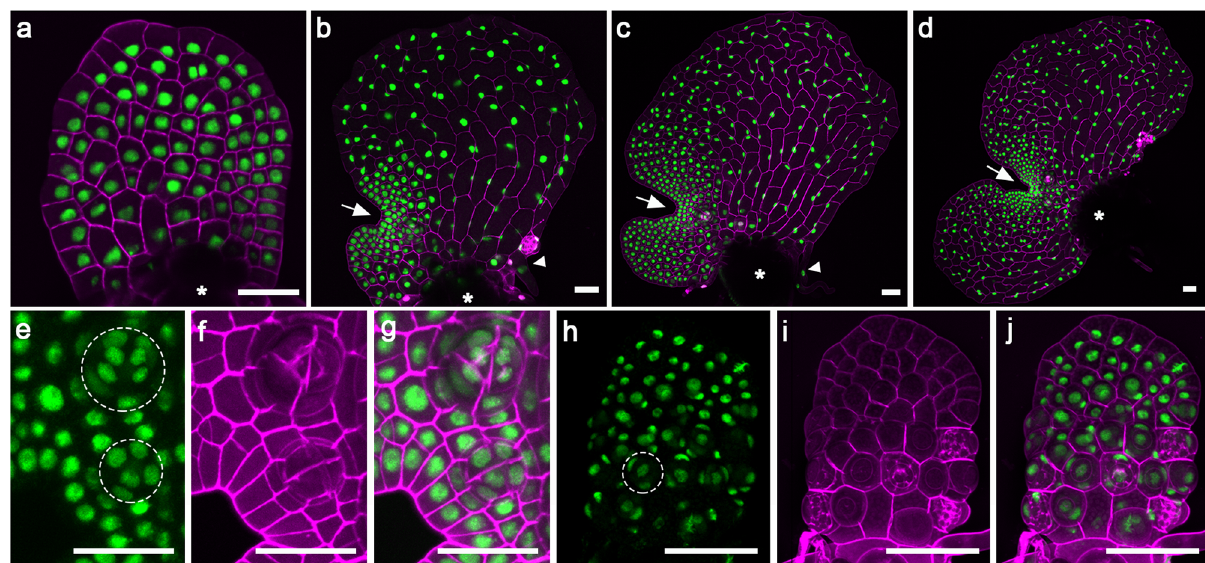
Fig. 1 Confocal imaging of Ceratopteris gametophytes expressing a fl uorescent nuclear marker at different developmental stages. a – j Ceratopteris gametophytes expressing the nuclear marker Histone 2B (H2B)-GFP were stained and imaged using laser scanning confocal microscopy. a – d Z-projection views of different hermaphroditic gametophytes at 7 days after inoculation, DAI ( a ), 9 DAI ( b ), 11 DAI ( c ), and 12 DAI ( d ). The white arrow indicates the meristem notch of each gametophyte. Asterisks indicate areas where spore coats are located. White arrowheads indicate rhizoids. e – g A close-up view of the meristem and adjacent archegonia in one hermaphroditic gametophyte at 13 DAI. Each archegonium is composed of multiple cells (nuclei) and highlighted with the dashed circle. h – j The z-projection view of a male gametophyte at 8 DAI. One antheridium is highlighted with the dashed circle. a – d , g , j Merge of GFP (green) and propidium iodide (PI, purple) channels. e , h GFP channel (green). f , i PI channel (purple). The transgenic line 24 was used for the confocal imaging in this fi gure. Scale bars: 50 μ